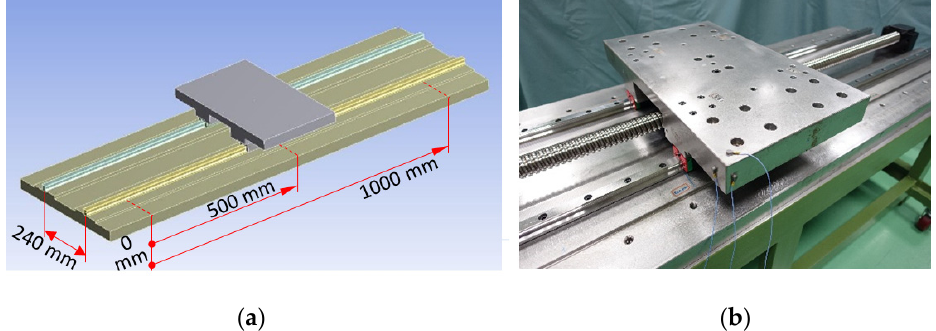
Figure 4. A single-axis positioning stage: ( a ) solid model and ( b ) stage prototype for test.